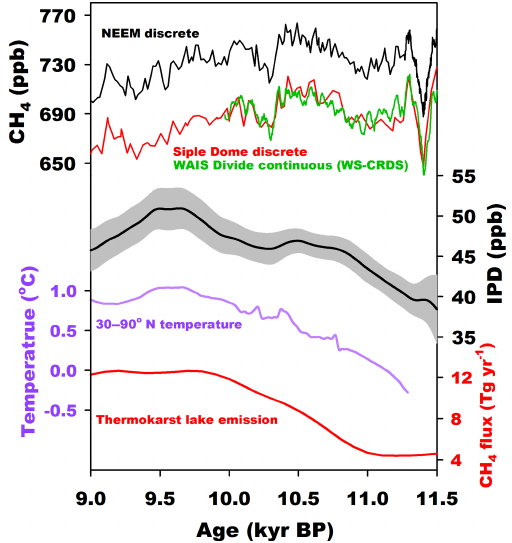
Figure 7. CH 4 inter-polar difference (IPD) and high-latitude CH 4 sources. Top: high-resolution CH 4 discrete measurements from NEEM discrete (black; Chappellaz et al., 2013), WAIS Divide con- tinuous (green; Rhodes et al., 2015), and Siple Dome (red, this study) ice core records. Middle: 1000-year low-pass-filtered com- bined IPD with 95% significance interval (shaded). Bottom: previ- ous estimates are marked in green and orange (Brook et al., 2000; Chappellaz et al., 2013). Proxy-based temperature reconstruction for 30–90 ◦ N (purple; Marcott et al., 2013). CH 4 flux estimate from Siberian and Alaskan thermokarst lakes (red; Walter Anthony et al.,